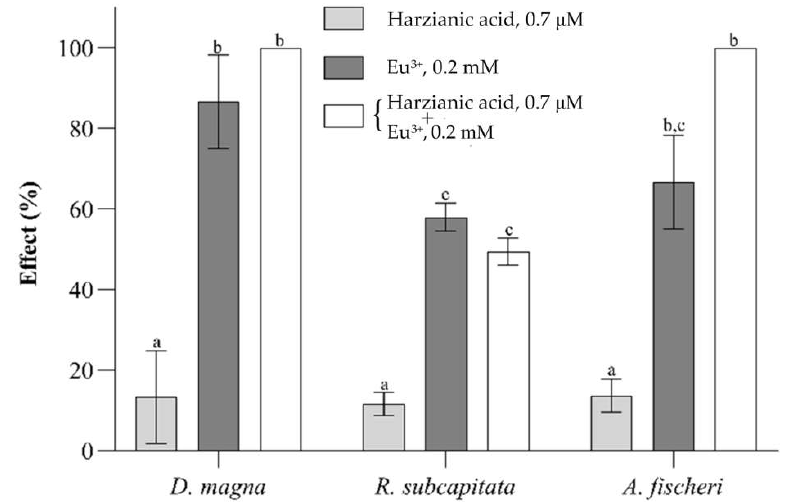
Figure 8. Results of ecotoxicity bioassays performed on D. magna (acute immobility test), R. subcapitata (chronic algal growth inhibition test), and A. fischeri (acute luminescence inhibition test) exposed, respectively, to 0.7 µ M harzianic acid, 0.2 mM Eu 3+ , and (0.2 mM Eu 3+ + 0.7 µ M harzianic acid). Data are reported as mean ± SD ( n = 3). Letters (a–c) indicate significant differences between treatments; the level of significance was set at α = 0.05 (ANOVA).